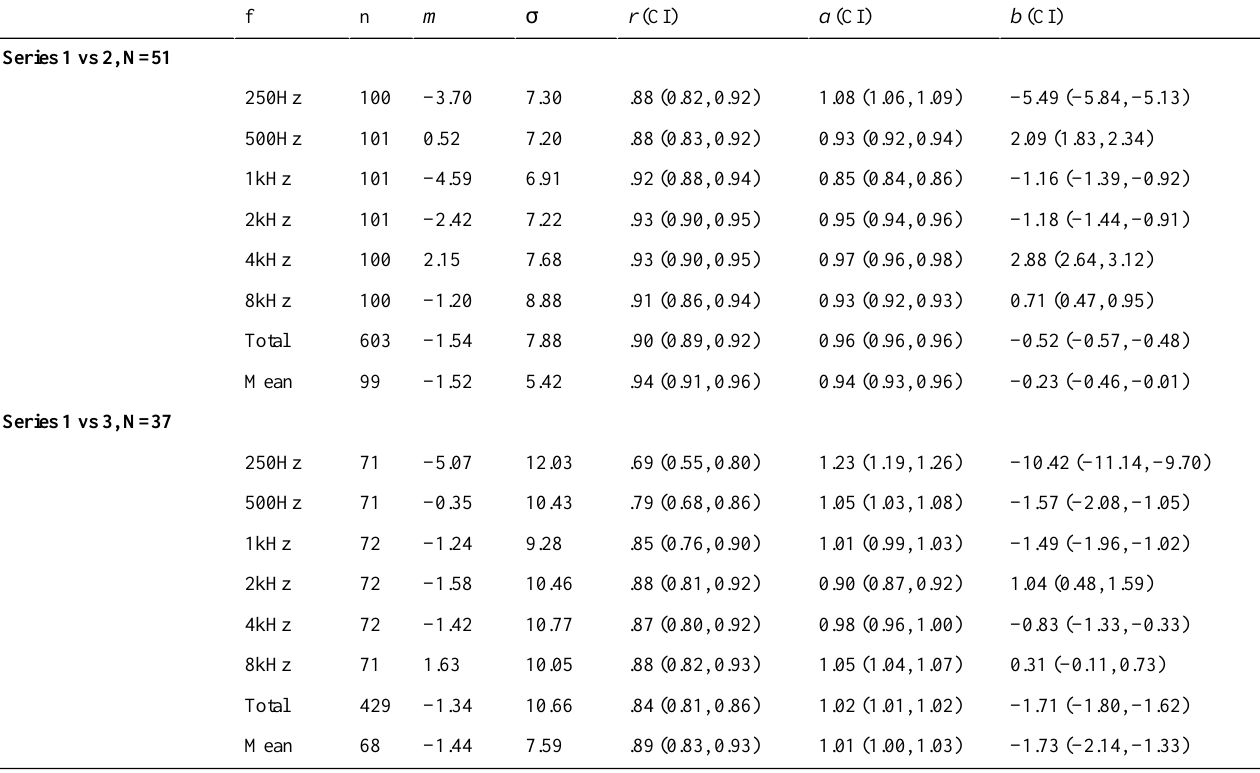
Table 1. The mean difference m in the hearing threshold value between the series calculated on the basis of n data points collected on a group of N subjects, its standard deviation σ , Pearson’s correlation coefficient r and linear estimators a , b of Deming’s regression y = ax + b and corresponding confidence intervals CI at P =.05.